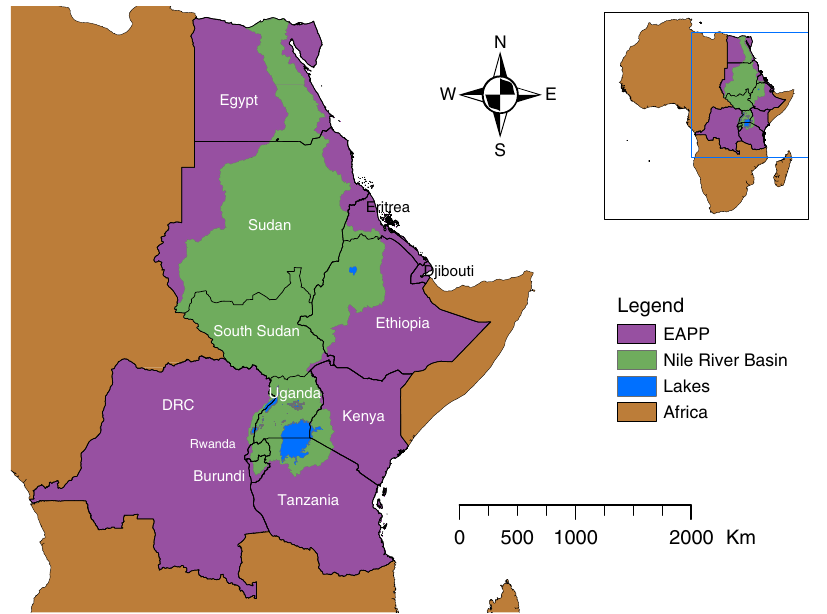
Fig. 1 The Nile River Basin and the EAPP countries. The Nile River Basin spreads across countries in East Africa, which constitute an institution called the Eastern African Power Pool